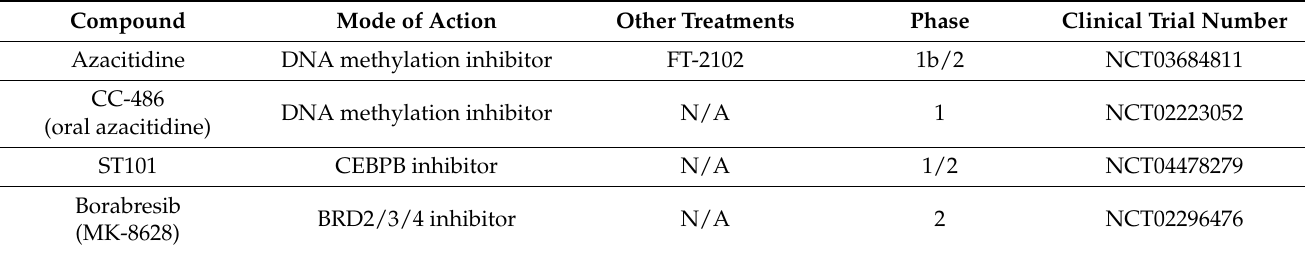
Table 2. Clinical trials are testing epigenetic therapies against a wide range of